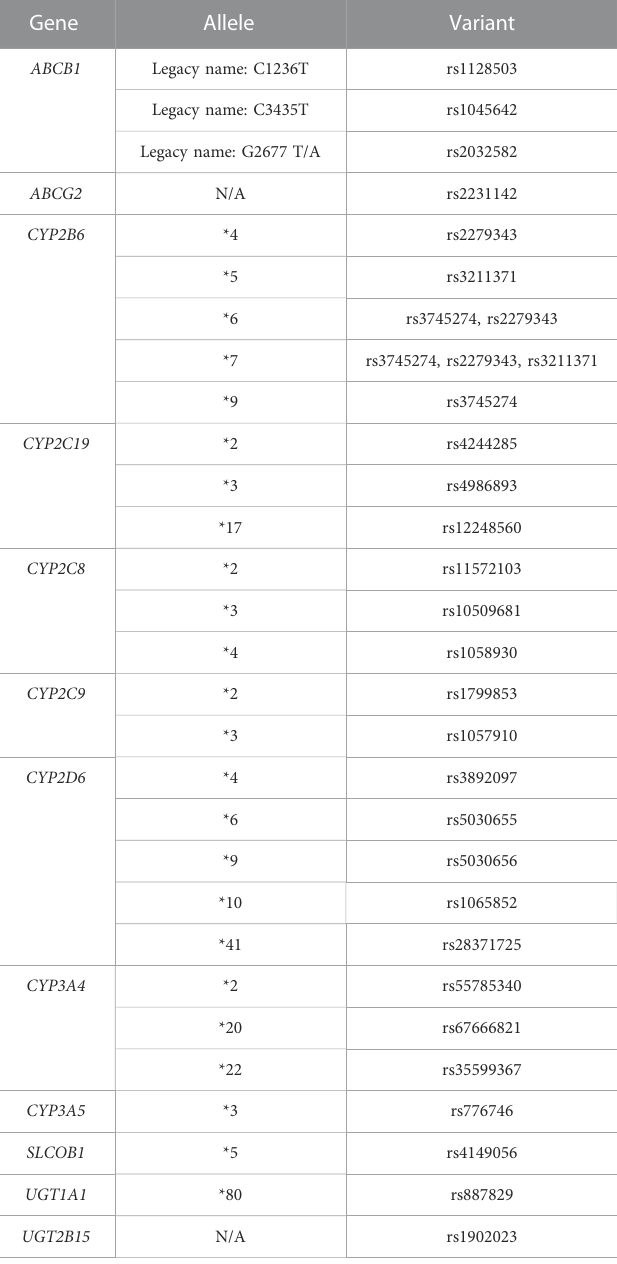
TABLE 1 Genes, alleles, and variants genotyped and